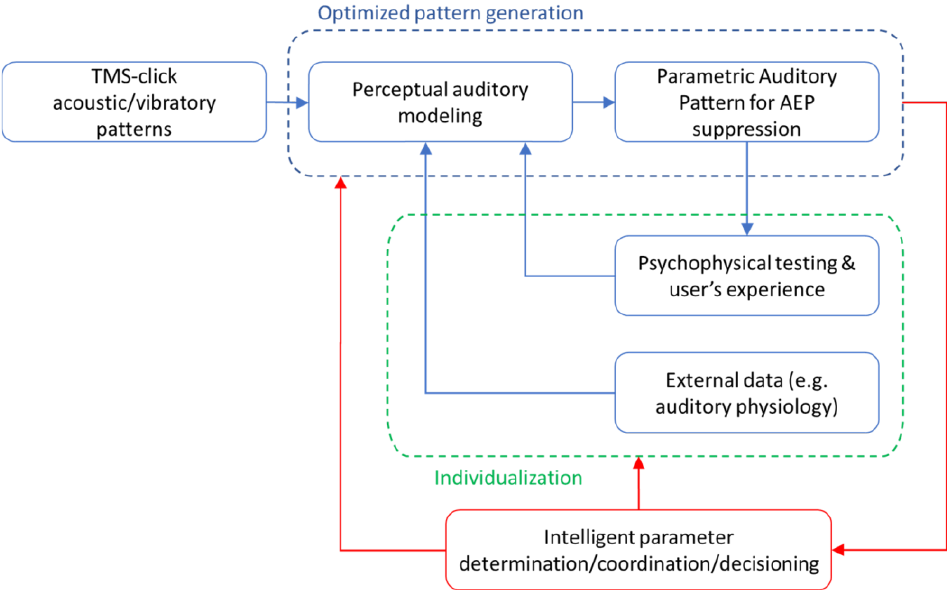
Figure 7. Advanced features and functionality of the proposed approach.